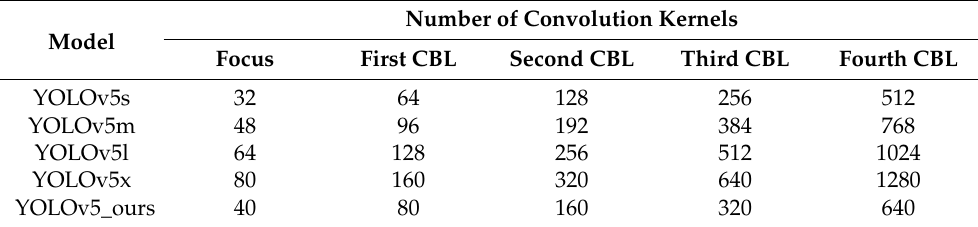
Table 4. Network width comparison of different YOLOv5 models.